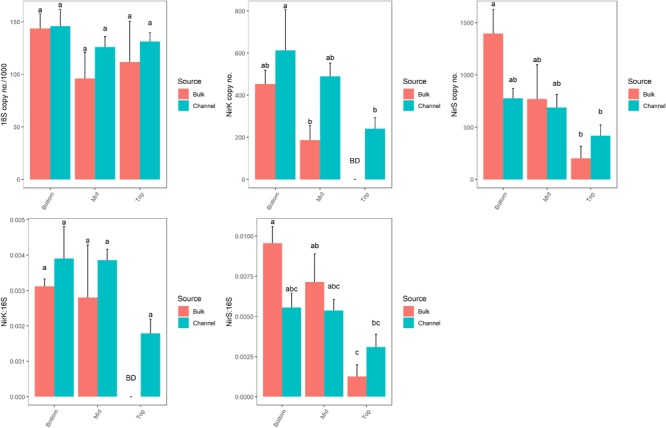
Abundances of 16S rRNA, nirK and nirS gene copy numbers from bulk soil and earthworm channels among landscape slope positions. Different letters above bars indicate statistically significant differences (Tukey’s HSD, p < 0.05). A statistical evaluation of differences is also presented in Supplementary Table 5.